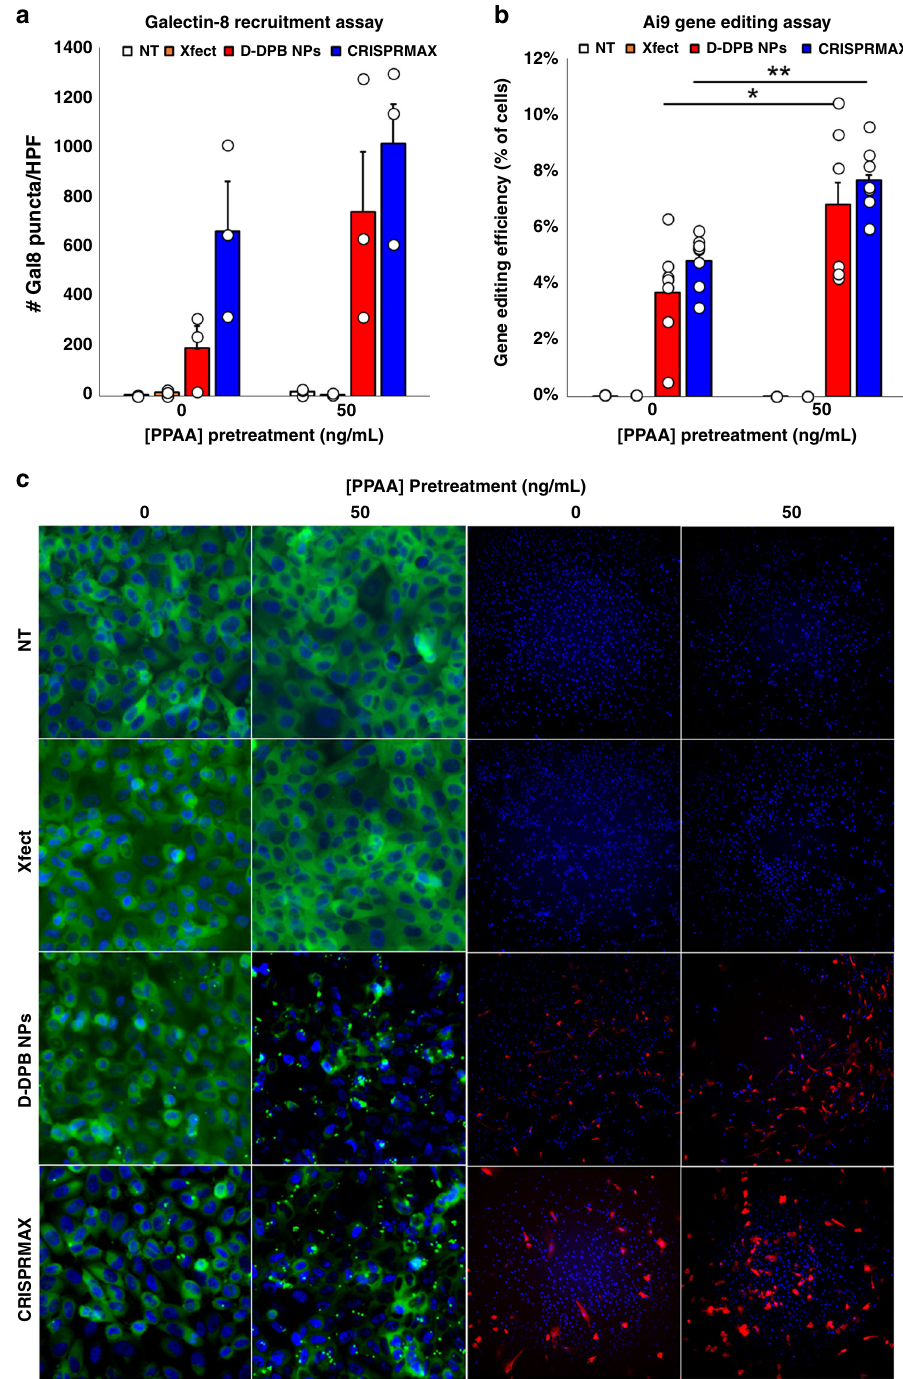
Fig. 7 PPAA enhances endosomal escape and gene editing ef fi ciency. Comparison of a Galectin-8 recruitment and b gene editing ef fi ciency with various delivery systems with and without PPAA pretreatment (50 ng/mL); * p < 0.05. ** p < 0.01; one-way ANOVA followed by a Tukey ’ s post hoc test. Data are presented as means± SEM. Successful CRISPR/Cas9-mediated gene editing leads to removal of a termination cassette upstream of a tdTomato transgene in Ai9 fi broblasts, leading to activation of tdTomato expression. c Representative microscopy images of galectin-8-YFP recruitment to disrupted endosomes and tdTomato expression following CRISPR/Cas9-mediated gene editing in engineered Ai9 fi broblasts. All Gal8 micrographs shown are 458.6 × 458.6 µ m; all Ai9 micrographs shown are 1404 × 1404 µ m. 50 ng/mL = 2.27 nM